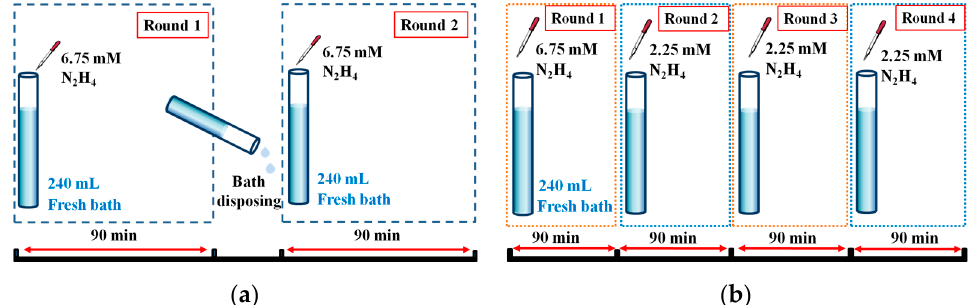
Figure 1. Schematics of the two approaches of hydrazine addition employed in this work: ( a ) one- time addition; ( b ) sequential addition.